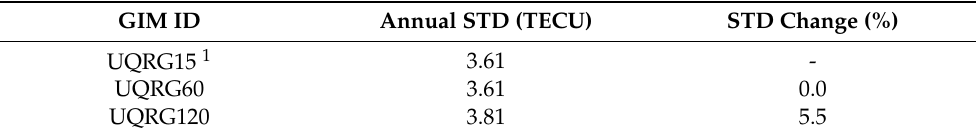
Table 5. Annual STD from Alt-VTEC comparisons for all analyzed GIMs in 2014.